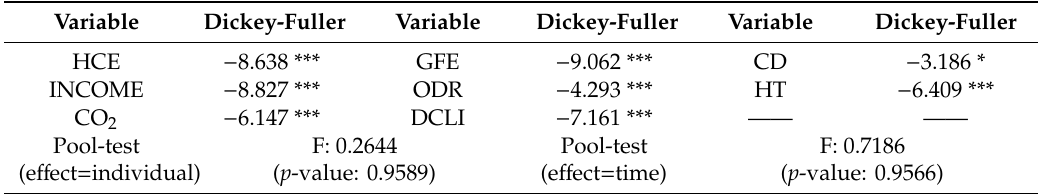
Table 4. Results of panel stability test—augmented Dickey-Fuller test